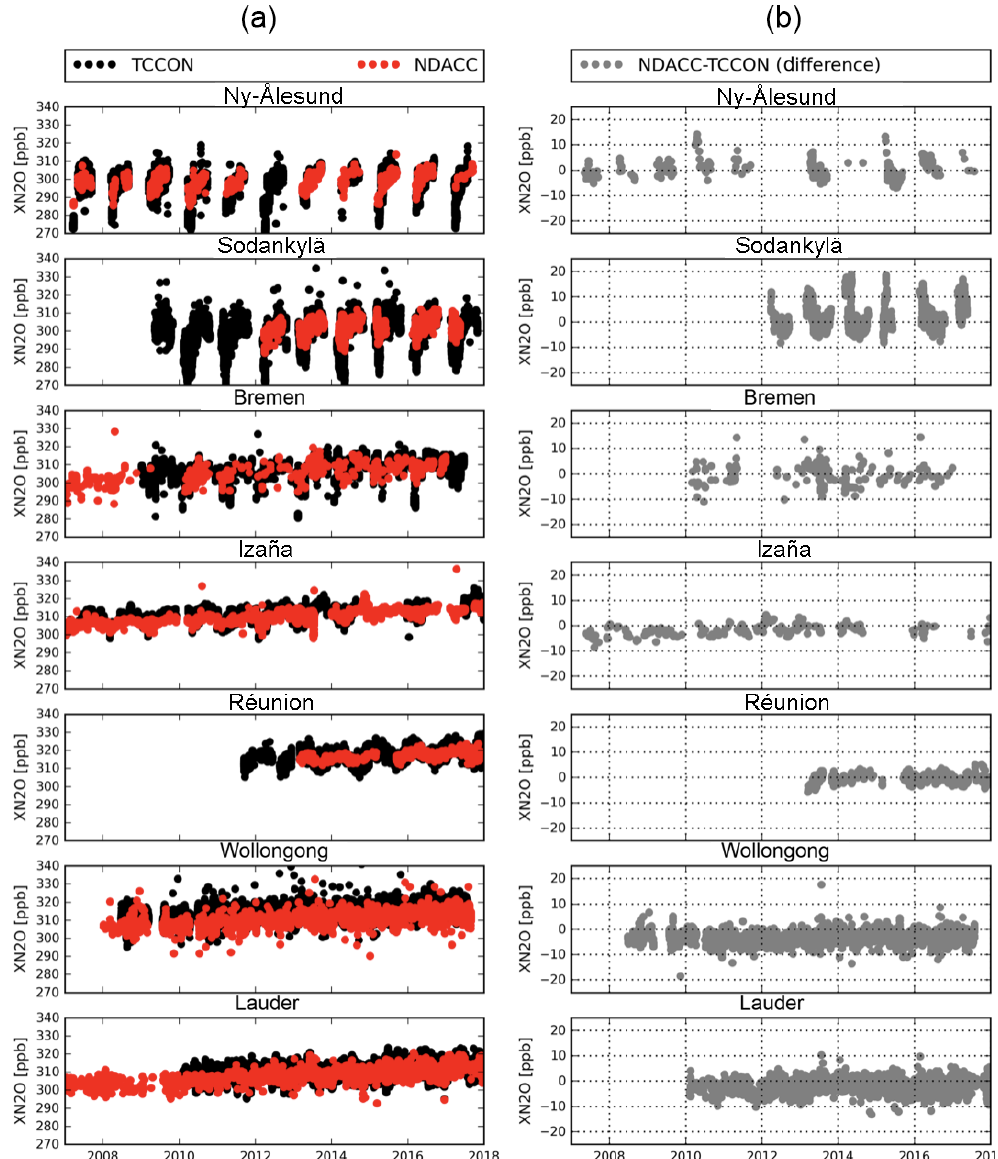
Figure 3. Time series of TCCON- and NDACC-retrieved X N co-located hourly means (b) at seven sites.